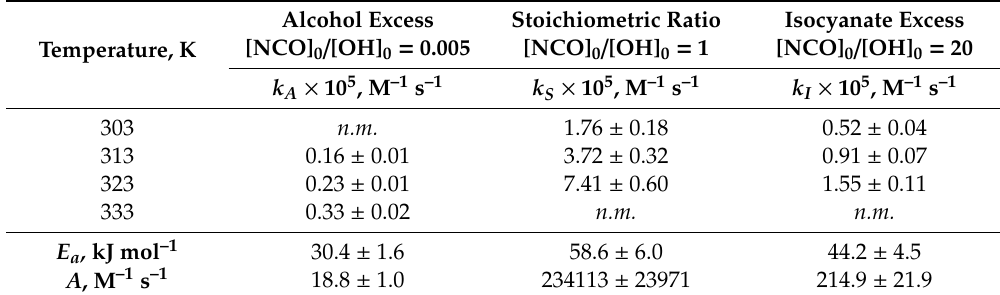
Table 1. Experimental reaction rate constants ( k A , k S and k I ) at di ff erent temperatures, Arrhenius Table 2. G4MP2 thermochemical properties calculated in 1-propanol (PrOH) and in tetrahydrofuran activation energies ( E a ) and pre-exponential factors ( A ). E a and A values were obtained by the method (THF), including zero- point corrected relative energies (Δ E 0 ), relative enthalpies (Δ H (T)) and relative of least squares. For [NCO] 0 / [OH] 0 = 0.005, data are taken from [11]. (n.m. = not measured). Gibbs free energies (Δ G (T,P)) at T = 298.15 K, and P = 1 atm. (A) according to alcohol excess, and according to isocyanate excess (I). All values are in kJ/mol.